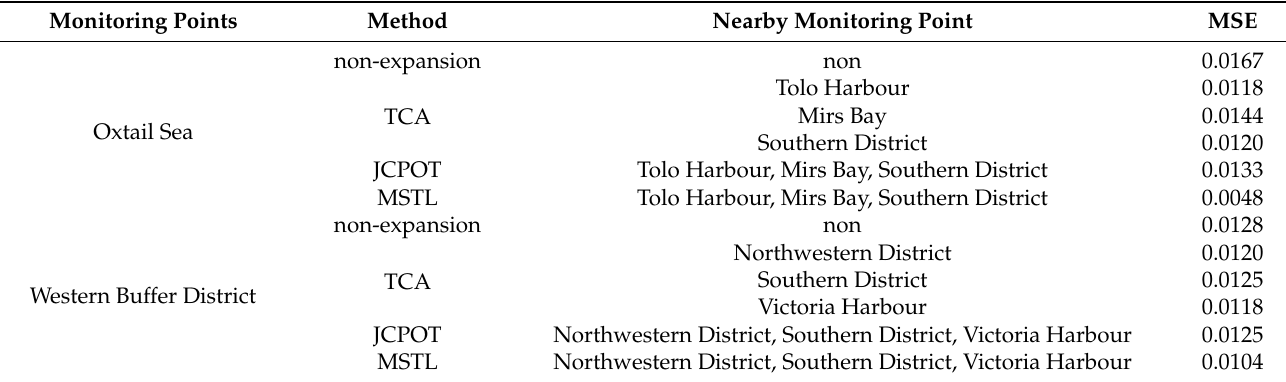
Table 3. Prediction results of different transfer methods in the Oxtail Sea and the Western Buffer District. Monitoring